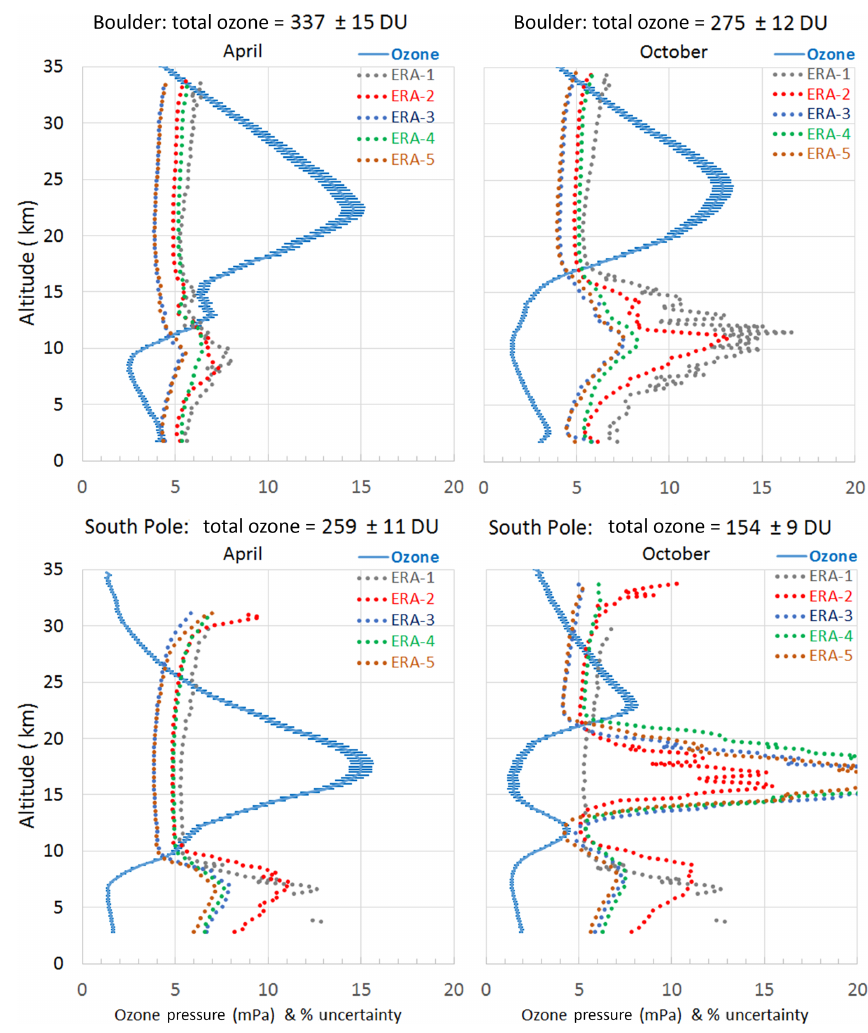
Figure 7. Ozone partial pressure and average relative uncertainty for each era vs. altitude for Boulder, CO, and South Pole for April and